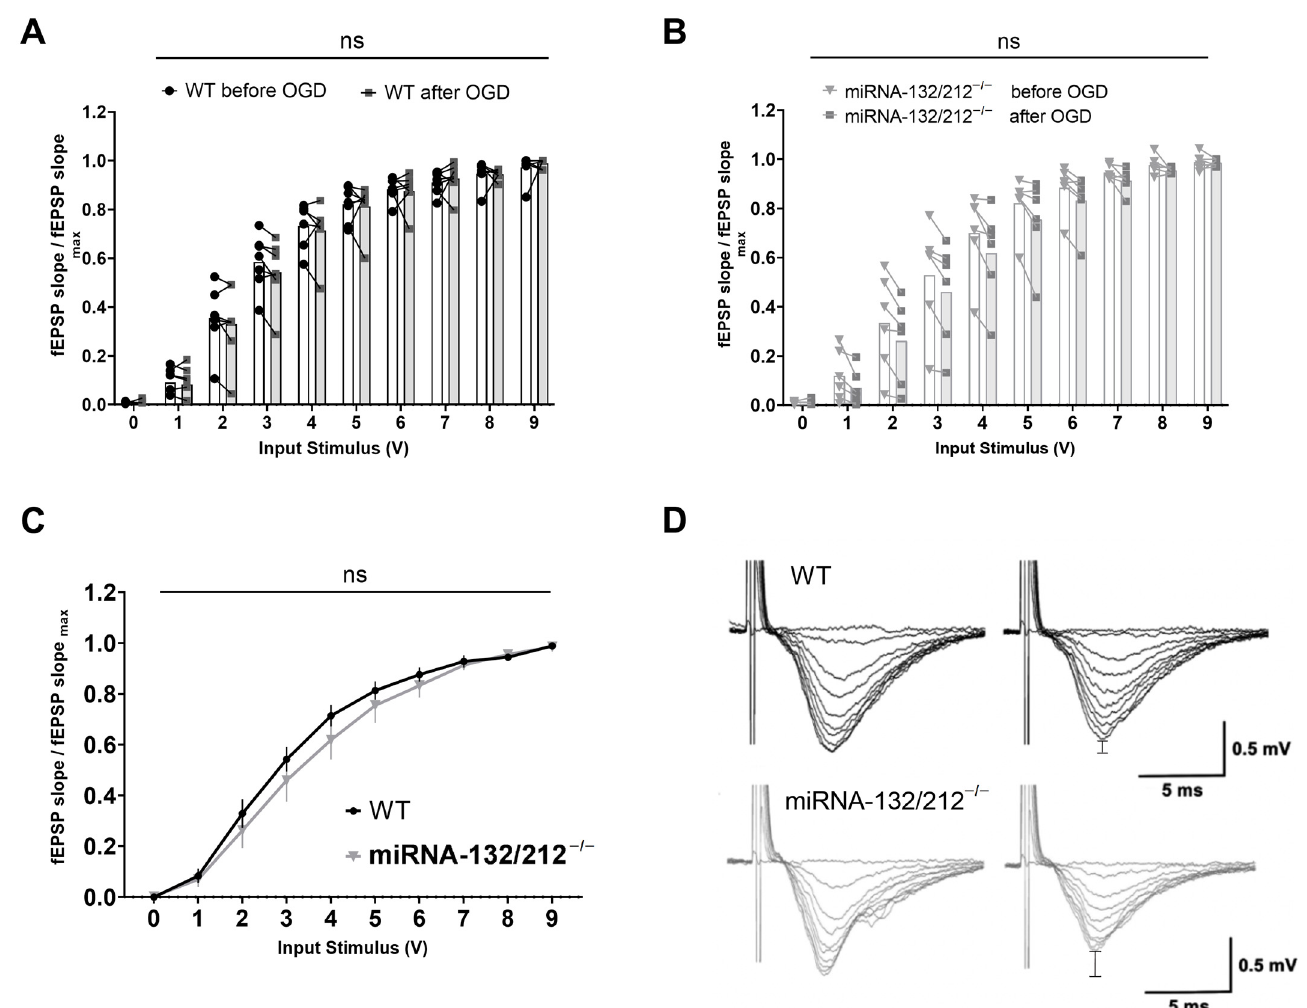
Figure 5. Repeated OGD did not significantly alter basal synaptic transmission in either genotype. I/O curves generated by plotting normalized fEPSP slope changes versus increasing pulses of input stimulation voltages obtained in WT ( n = 7) and miRNA-132/212 − / − mice ( n = 6) hippocampal slices. Separate two-way ANOVAs with repeated measures comparing basal synaptic transmission recorded before and after OGD treatment in WT dentate gyri ( A ) and miRNA-132/212 − / − dentate gyri ( B ) did not reveal statistically significant differences. ( C ) Normalized fEPSP slopes obtained from WT and miRNA-132/212 − / − slices after OGD treatment did not differ significantly. ( D ) Representative raw fEPSP traces recorded from hippocampal slices obtained from WT mice (upper row) and miRNA-132/212 − / − mice (lower row) in response to ascending stimulus intensities before (left) and after (right) OGD treatment. In both cases, the differences in the peak amplitudes before and after OGD are emphasized in the right panels by vertical bar indicators. Data is presented as mean ± SEM. fEPSP: field excitatory postsynaptic potential, OGD: Oxygen Glucose Deprivation. ns: no statistical significance.